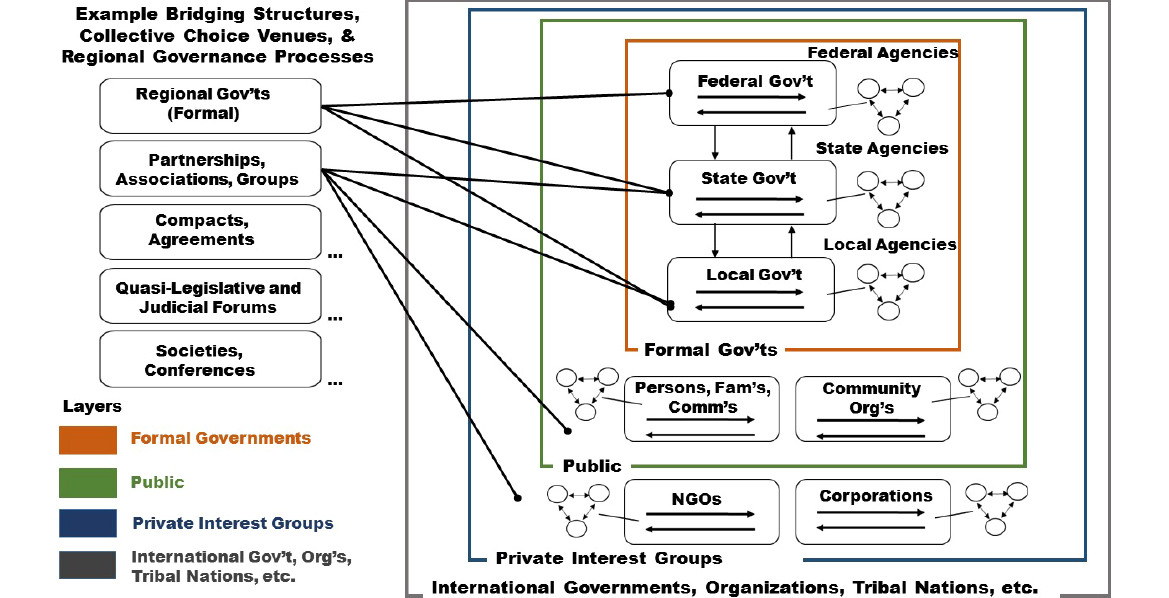
Fig. 1 . Example centers of activity in environmental governance. Layers represent linked social systems or subsystems within society. Rounded boxes (e.g., Federal Gov’t) represent centers of environmental governance activity or decision-making situations (e.g., policy making), which may be involved in adaptive governance. Circles represent subunits within centers (e.g., Federal Agencies), and are also decision situations. Arrows depict structural, procedural (e.g., informational, decision-making), and institutional (rule-governed) linkages and interactions; these ties may be strong or weak, depending on context. We assume that centers and layers are linked (not shown for clarity). This representation is not intended to imply a particular priority, or hierarchy, among layers/units; also, it is not exhaustive, but illustrative. Adapted and expanded from Sarker